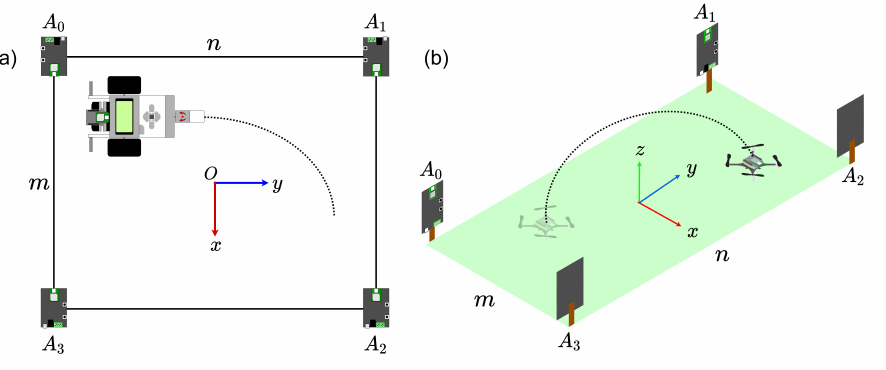
Figure 6. Diagram of the characterization experiment. ( a ) In 2D. ( b ) In 3D.